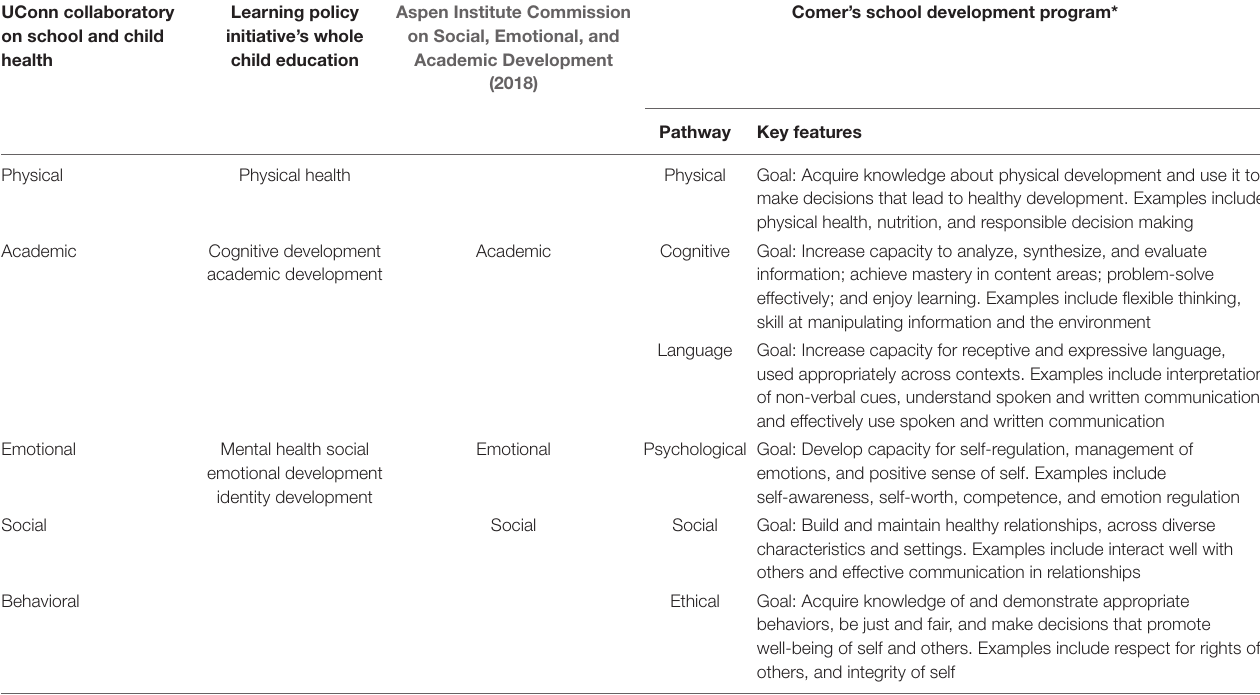
TABLE 1 | Description of Comer’s six developmental pathways, including alignment with other whole child